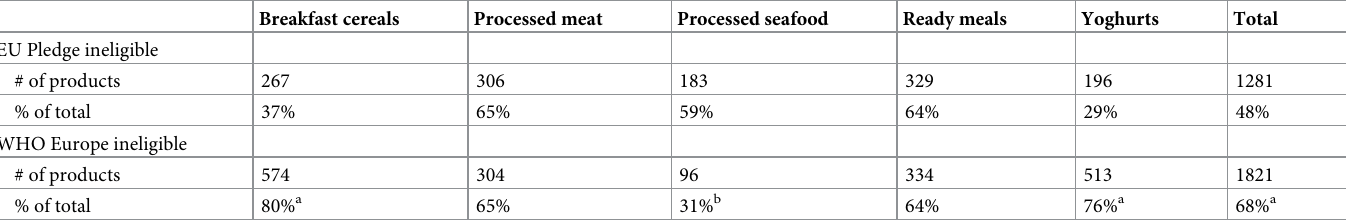
Table 3. Number and percentage of products from the Euromonitor Nutrition 2016 database not passing the EU Pledge and WHO Europe nutrient profile model criteria, respectively, by category and overall. Breakfast cereals Processed meat Processed